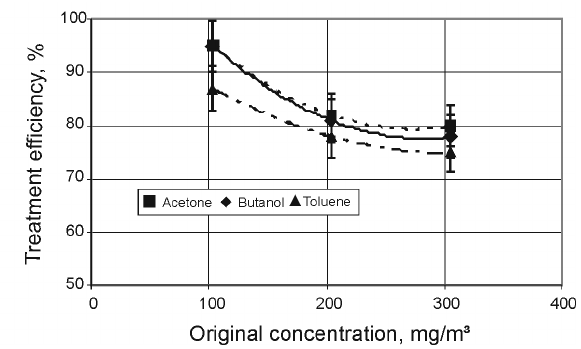
Fig. 9. Dependence of biofilter treatment efficiency on the concentration of the supplied